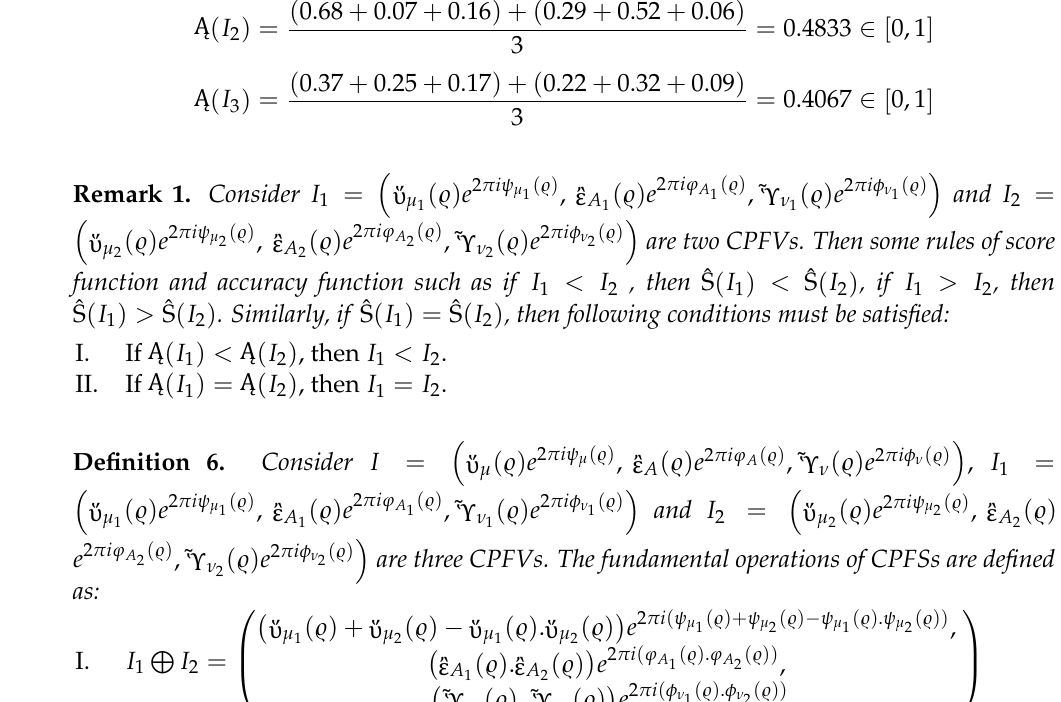
Table 1. Symbols and their meanings.